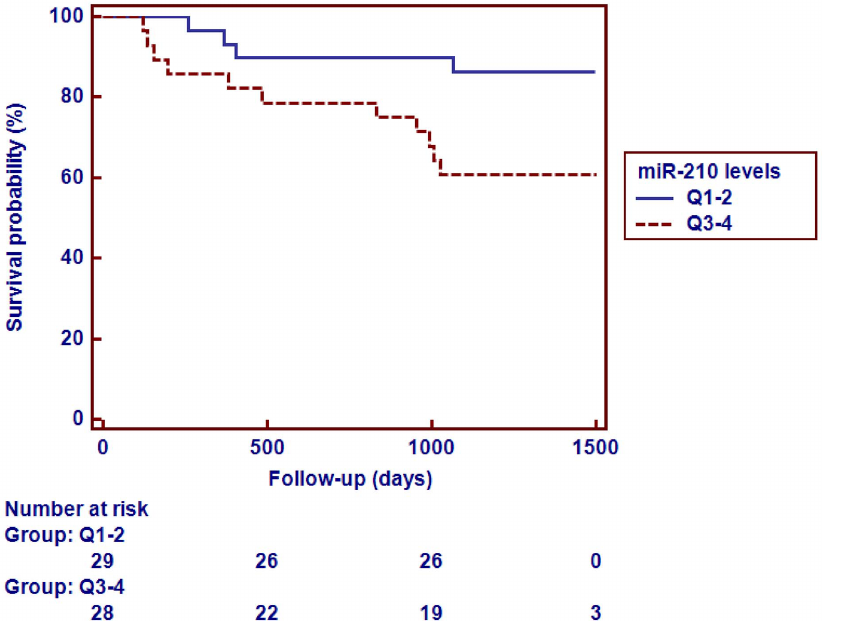
Figure 3. Assosciation between miR-210 levels and mortality during follow-up with miR-210 levels divided by the median (p=0.029 by the log-rank